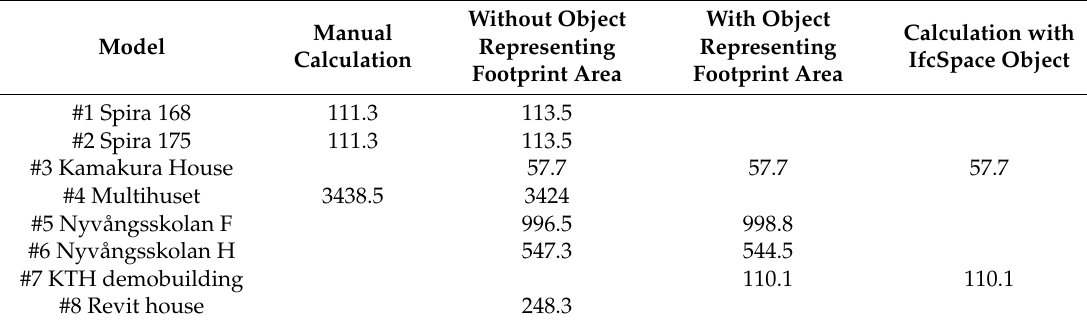
Table 3. Compilation of calculated footprint areas. Areas presented in m 2